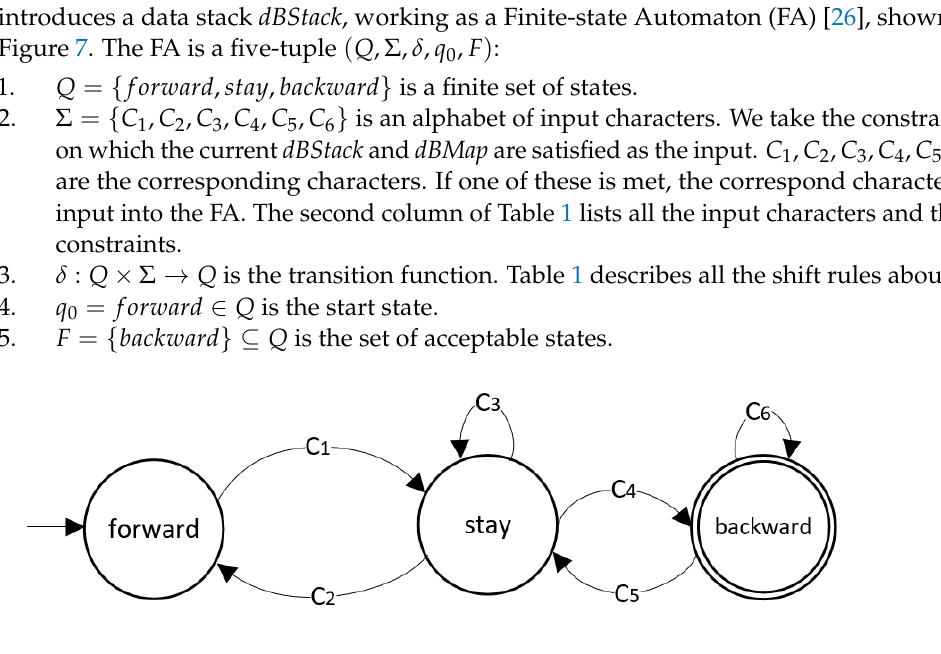
Figure 7. The FA of de Bruijn-based test case